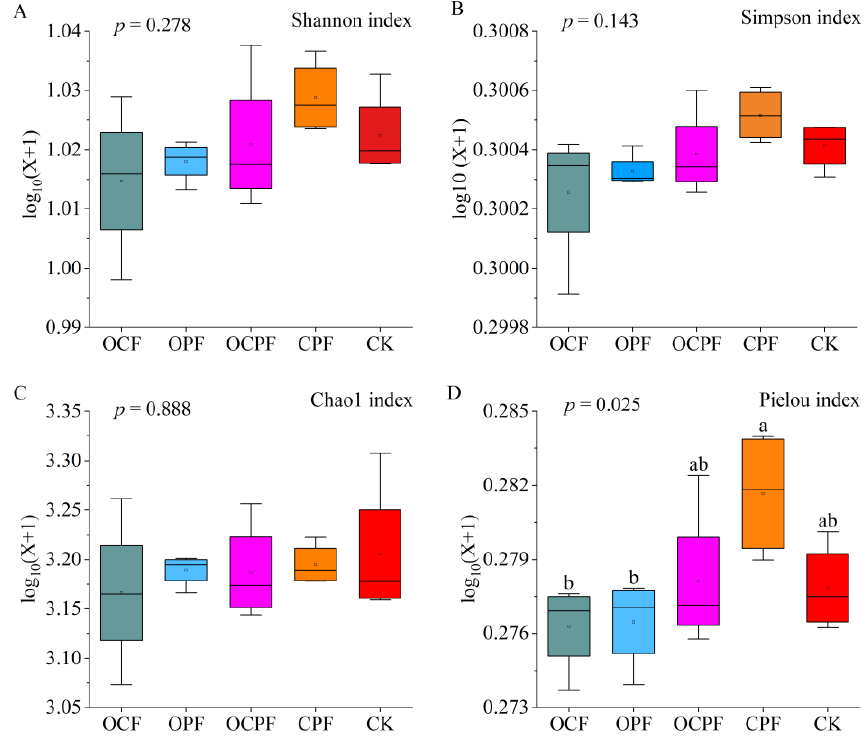
Figure 1. Alpha diversity indexes ( n = 4) of bacterial communities between different fertilization treatments. ( A ), Shannon index; ( B ), Simpson index; ( C ), Chao1 index; ( D ), Pielou index. OCF, application of organic fertilizer and NPK compound fertilizer; OPF, application of organic and CaMgP fertilizers; OCPF, application of organic, NPK and CaMgP fertilizers; CPF, application of NPK and CaMgP fertilizers; CK, no fertilization. Lowercase letters indicate statistical differences at a 0.05 significance level among treatments.